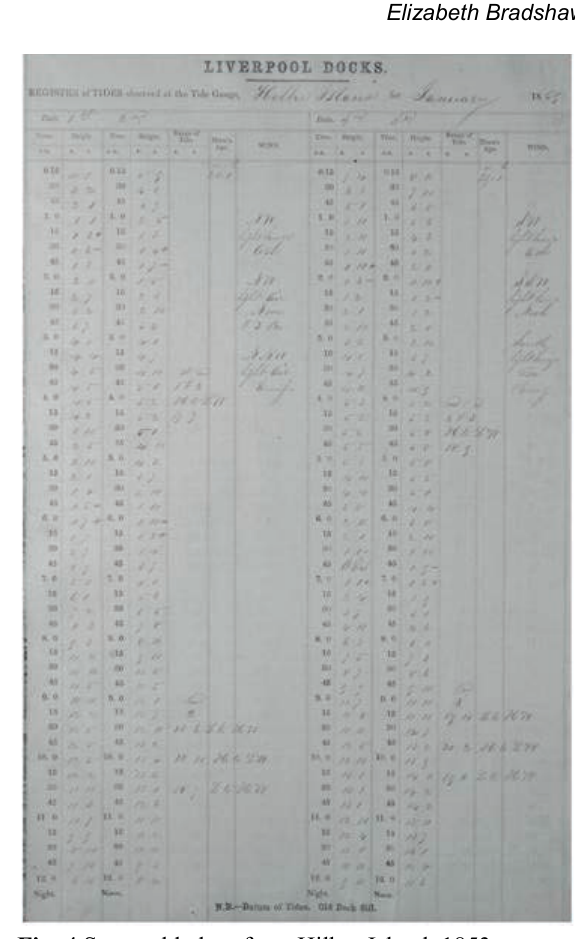
Fig. 4 Scanned ledger from Hilbre Island,